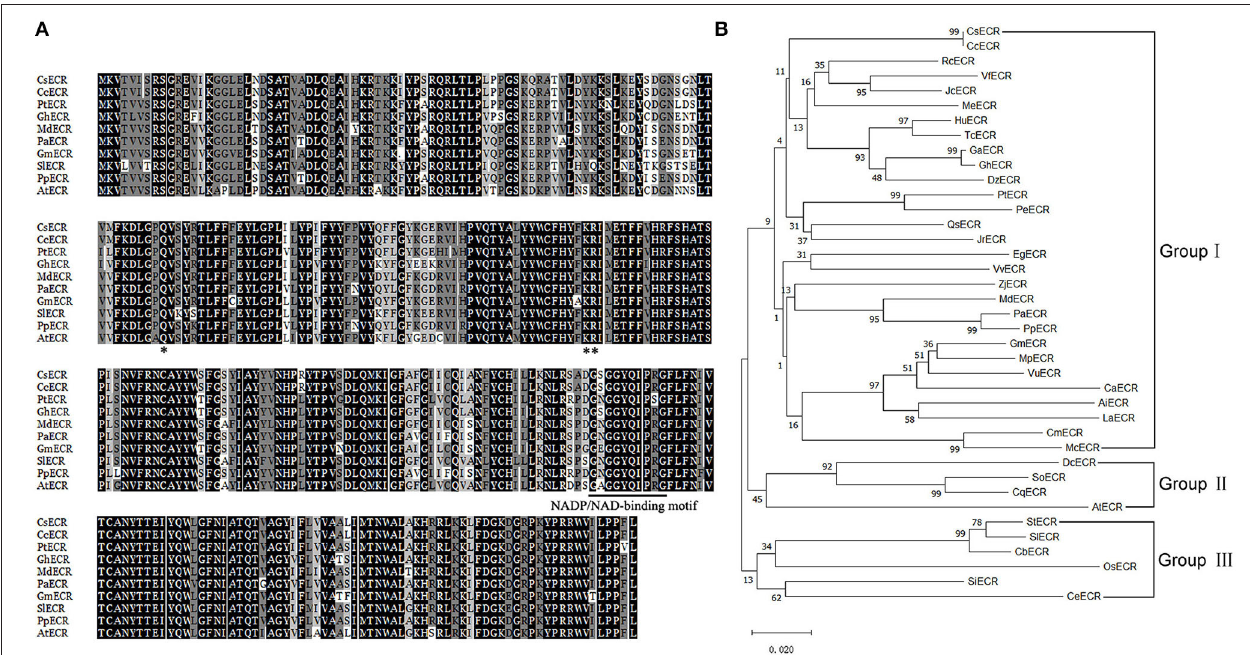
FIGURE 1 | Multiple sequence alignment (A) and phylogenetic analysis (B) of CsECR with its homologous proteins from different plant species, including Citrus clementina CcECR (XP_006435990.1), Ricinus communis RcECR (XP_002530850.1), Vernicia fordii VfECR (AHI86054.1), Jatropha curcas JcECR (XP_012089325.1), Manihot esculenta MeECR (XP_021618477.1), Herrania umbratical HuECR (XP_021295484.1), Theobroma cacao TcECR (XP_007009348.1), Gossypium arboretum GaECR (GenBank accession number XP_017620211.1), Gossypium hirsutum GhECR (NP_001314306.1), Durio zibethinus DzECR